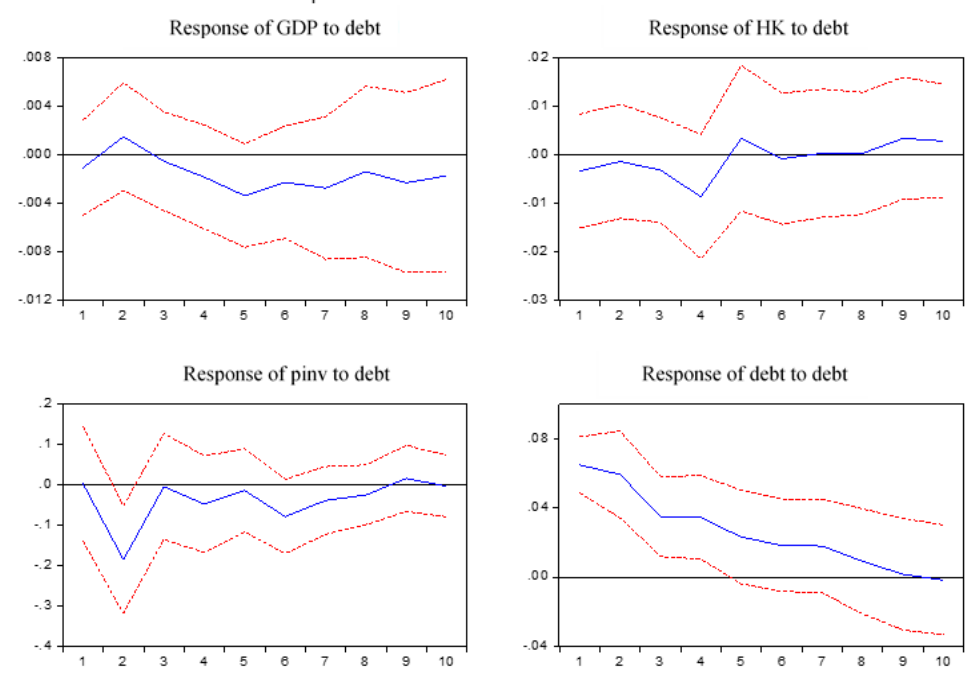
Figure 3: Response of Government Debt, Private Investment, Per Capita Output and Hu - man Capital Stock to a Generalized 1 SD Innovation in Government Debt, Indonesia, 1985-